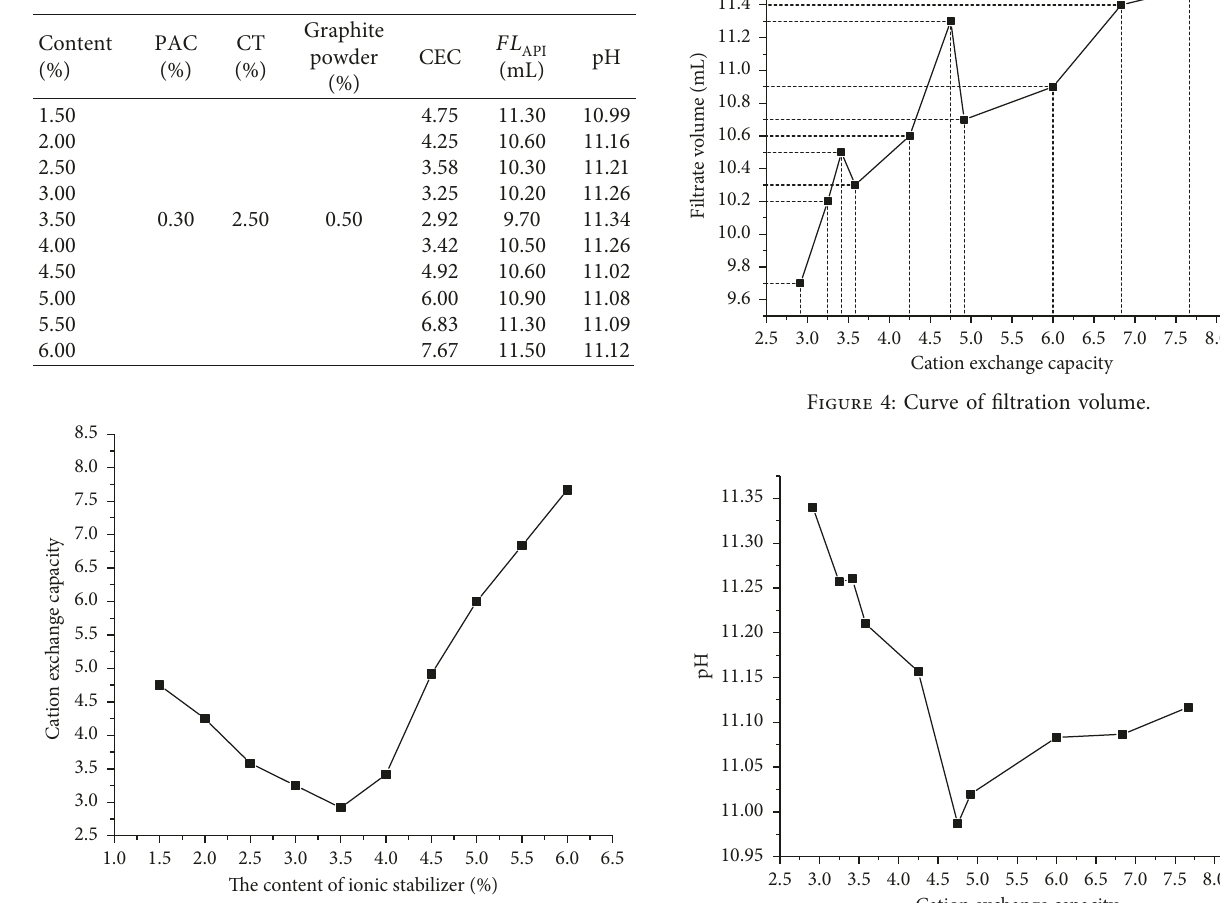
Table 1: Experimental results of slurry fluids with different con- tents of ionic stabilizer.